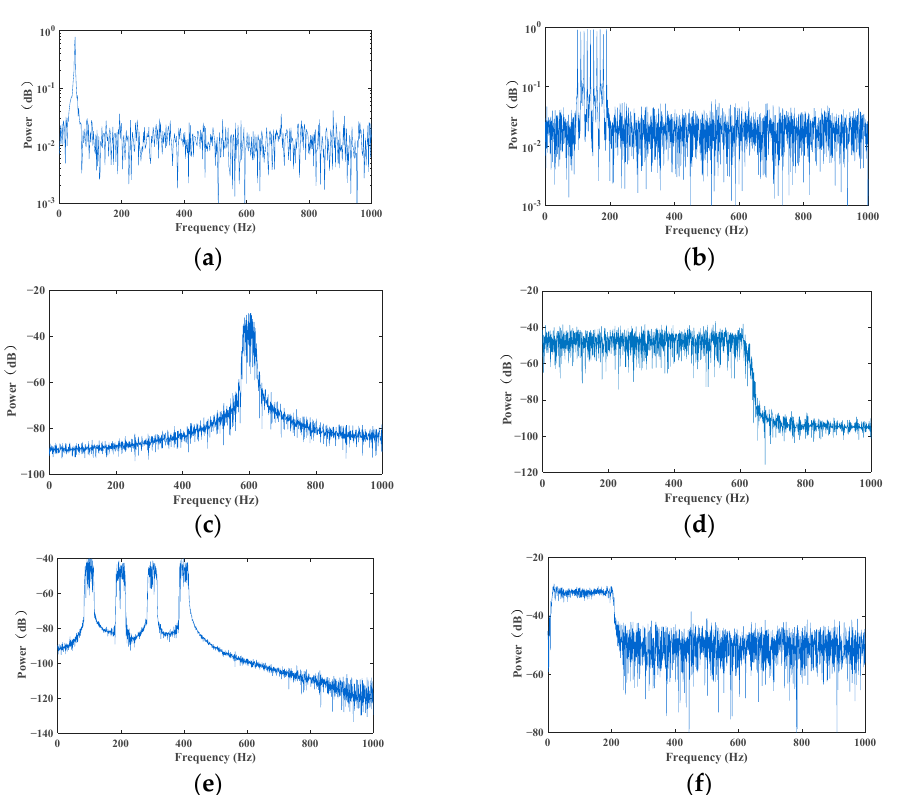
Figure 2. Amplitude spectra of six common jamming patterns (JNR = 10 dB). ( a ) Single-tone Jamming. ( b ) Multi-tone Jamming. ( c ) Narrow-band Jamming. ( d ) Broad-band Jamming. ( e ) Comb Jamming. ( f ) Sweep Jamming.